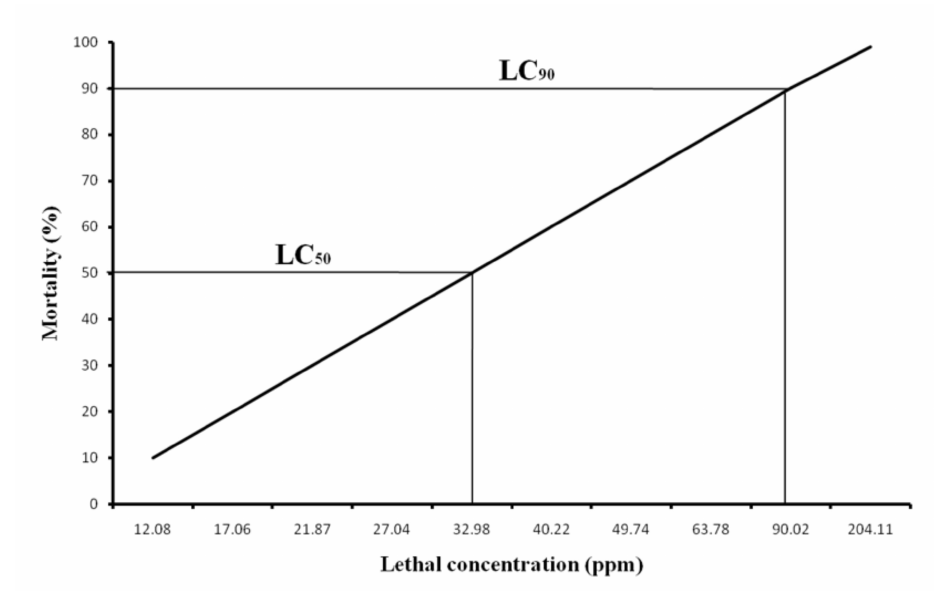
Figure 3. The calculated LC 50 and LC 90 values for 96 h study